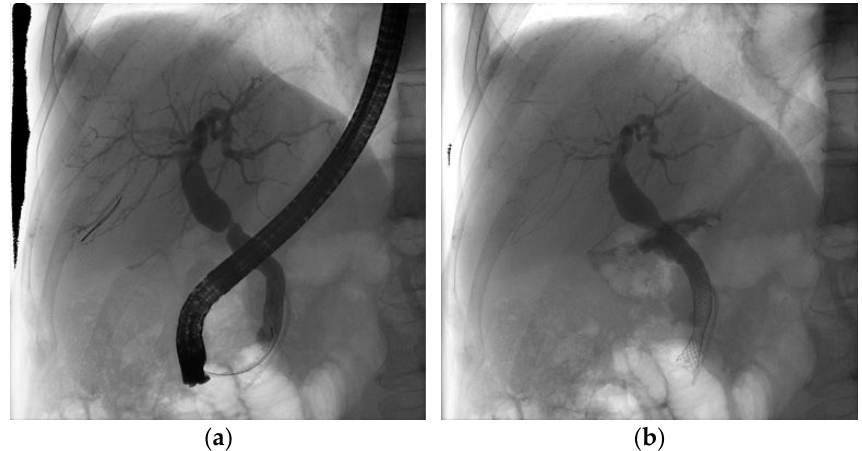
Figure 2. Cholangiogram of hilar biliary stenosis post OLT before ( a ) and after ( b ) expandable stent insertion.